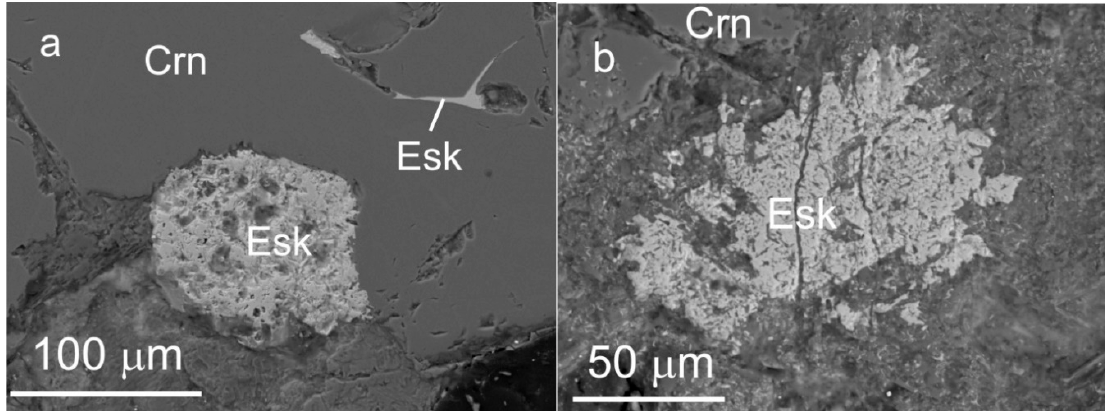
Figure 4. Back-scattered electron (BES) image of the eskolaite (Esk) ( a ) on type 1 ruby and ( b ) on type 3 ruby. Table 1. Eskolaite X ‐ Ray diffraction data. Eskolaite JCPDS Eskolaite with Ruby